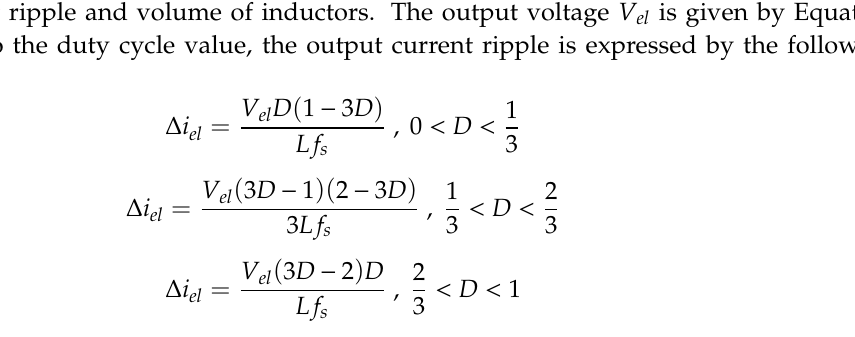
Figure 13. Six-pulse diode bridge rectifier with a three-phase interleaved buck converter. Each power switch (i.e., S 1 , S 2 , and S 3 ) is controlled with a phase shift angle of 120°, reducing